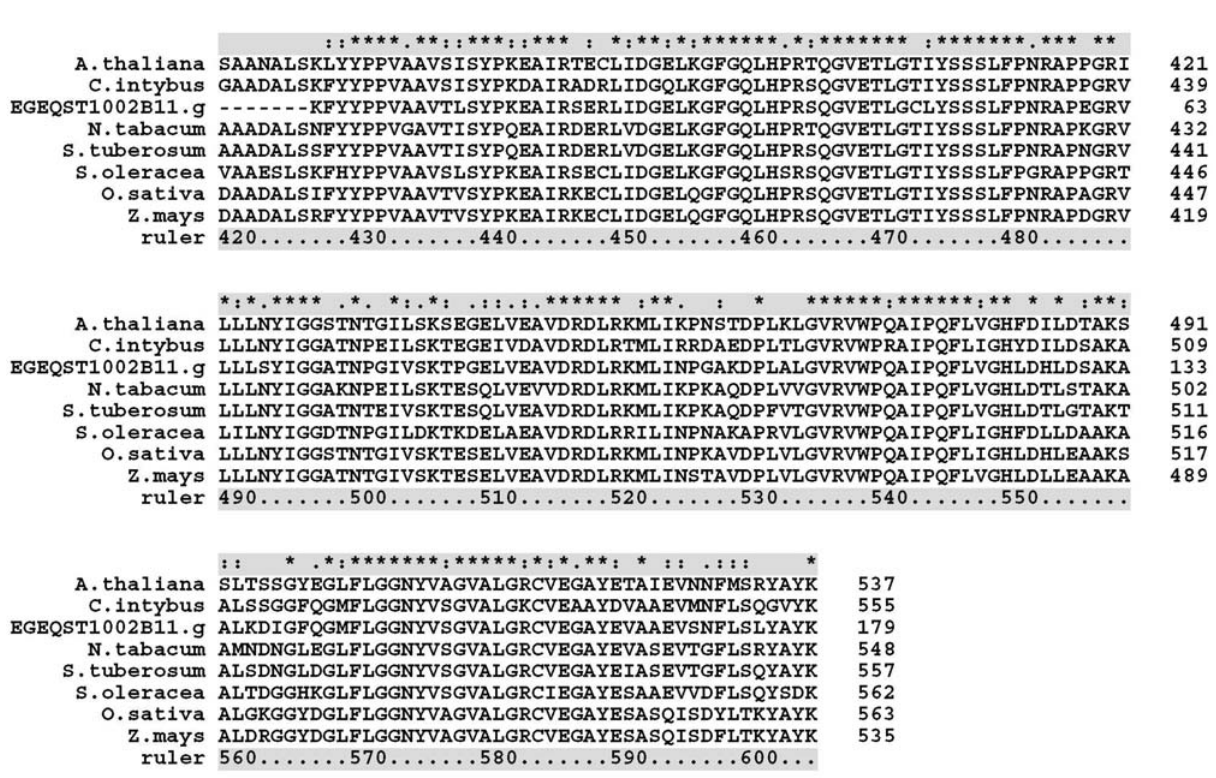
Figure3 -Graphicalrepresentationofthephylogeneticdistancesobtained from amino acid sequences corresponding to the start region of the en- zyme protoporphyrinogen IX oxidase of the studied species.